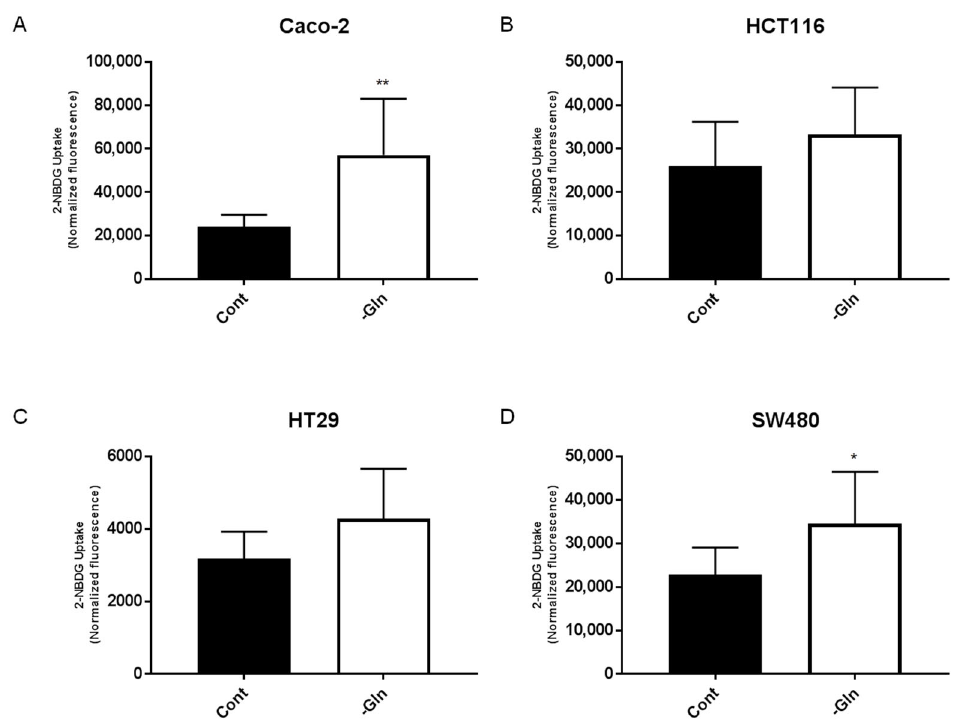
Figure 5. Colorectal cancer cell lines exhibited changes in glucose uptake under glutamine depriva- tion (( A ) Caco-2, ( B ) HCT116, ( C ) HT29, ( D ) SW480). Glucose uptake was measured through the quantification of the fluorescence emitted by the glucose analog 2-NBDG in cancer cells cultured in the presence or the absence of glutamine 4 mM for 48h. Data are presented as mean ± SD ( n = 3). Statistical analysis was performed by Student t-Test. Results were considered significant when * p < 0.05, ** p < 0.05.